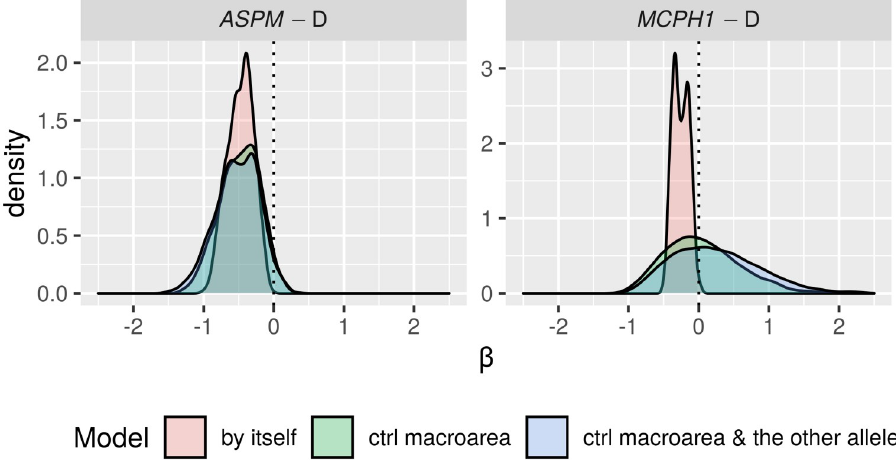
Fig 27. Distribution of the restricted sampling regressions for tone counts . Same conventions as in Fig 10.